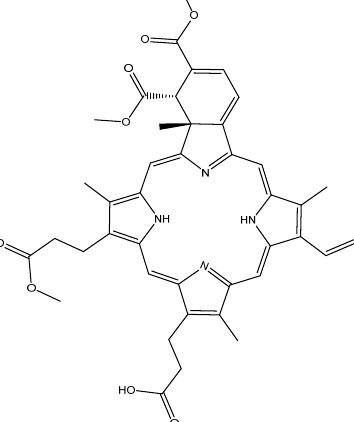
Figure 1. Schematic of a verteporfin molecule.